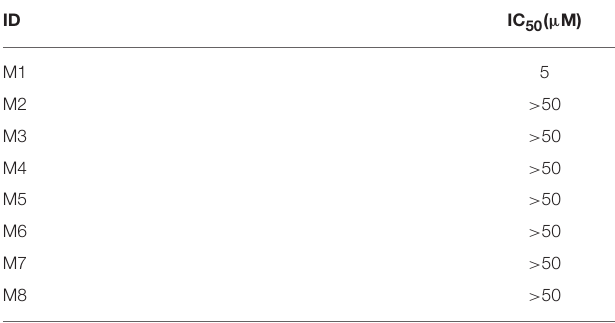
TABLE 3 | The IC 50 of eight small molecule compounds on breast cancer